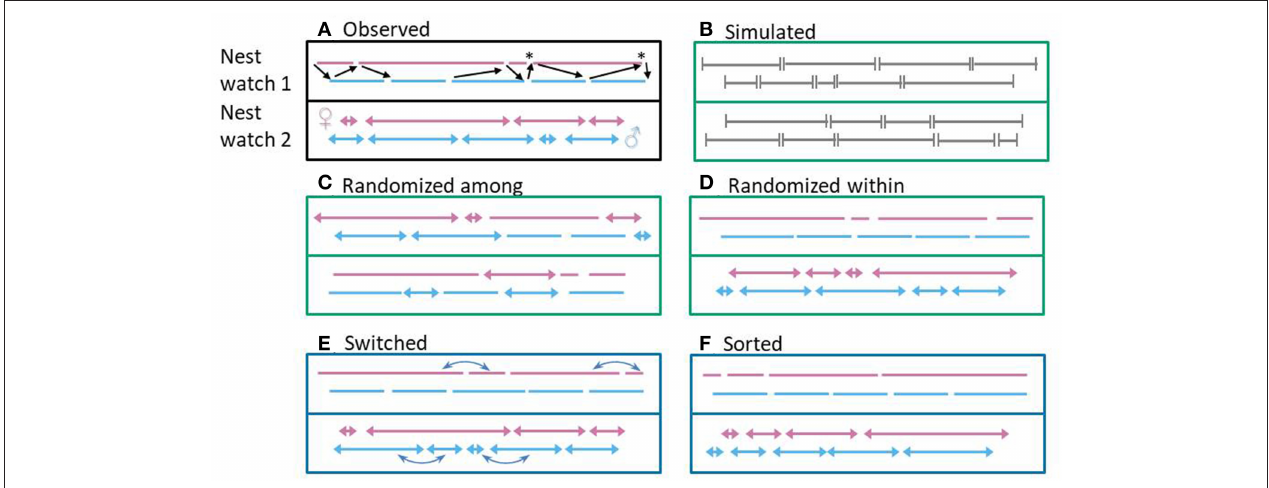
FIGURE 3 | Illustrative timeline of inter-feeding intervals for six datasets, with each line (nest watch 1) or arrow (nest watch 2) representing an interval (female and male visits in pink and light blue, respectively). Random datasets (randomized or simulated) are in green boxes, and those can be used as baseline expectation to compare the observed coordination. Datasets used to explore whether and how a shared environment can passively induce alternation are represented in blue boxes. In the first nest watch of the first dataset (A) , black arrows represent the transition from one partner to another, i.e., alternated visits. Note that one visit can be involved in zero, one, or two such transitions. Asterisks highlight synchronized visits. Five datasets are derived from the observed dataset (A): (B) intervals (in gray) were simulated according to the observed parameters (population mean and standard deviation of provisioning rate) to create patterns that do not contain any active coordination or environmentally induced alternation, and only contain alternation and synchrony occurring by chance, (C) observed intervals were randomized among individuals of the same sex and same provisioning rate, to break down active coordination and environmentally induced alternation, while maintaining the properties of observed intervals (e.g., potential refractory periods) (D) observed intervals were randomized within individual within nest watch to break down active coordination but maintain the interdependencies of intervals produced in a same overall environment (e.g., properties relative to the regularity of visits of a specific individuals), but probably does not include any finer-scale environmentally induced alternation, (E) consecutive observed intervals were switched in one randomly picked pair member (blue arrows) with the intent to break down some active coordination and maintain some environmentally induced alternation, and (F) observed intervals were sorted by length within each individual within nest watch to visualize the maximum possible alternation that could have been induced by a simultaneous directional change in interval length (given a set of intervals), which could be produced by the influence of a shared